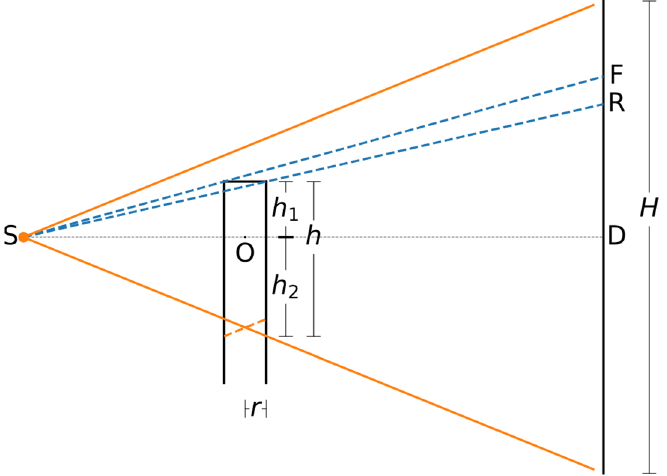
Figure 2. Geometric representation of the computed tomography (CT) scan (symmetric with respect to the central plane SOD).